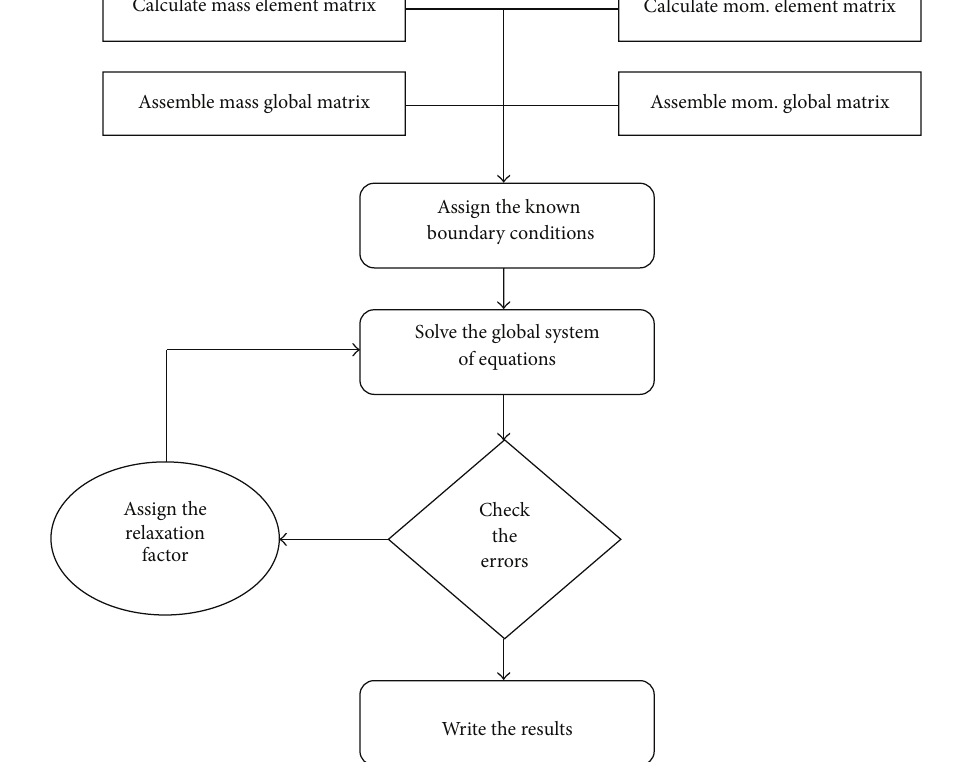
Figure 3: Solution procedure.